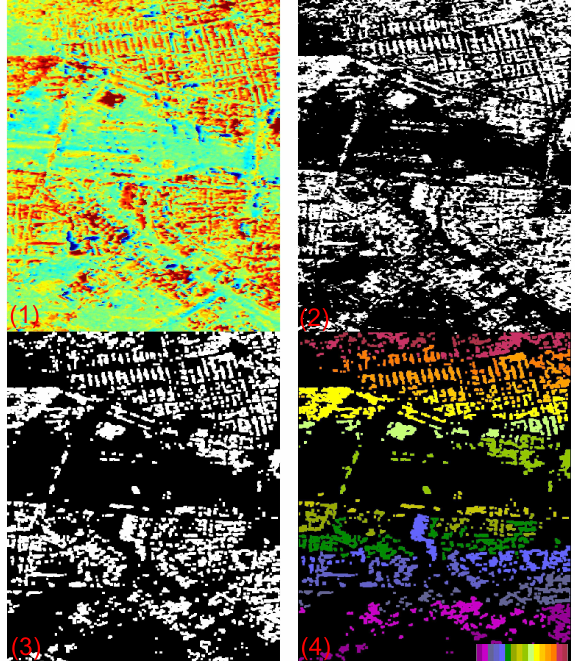
Figure 2: Processing result of the volume derivation chain for TanDEM-X Raw DEM. (1) DBM. (2) Binary Threshold. (3) Morphological operations. (4)